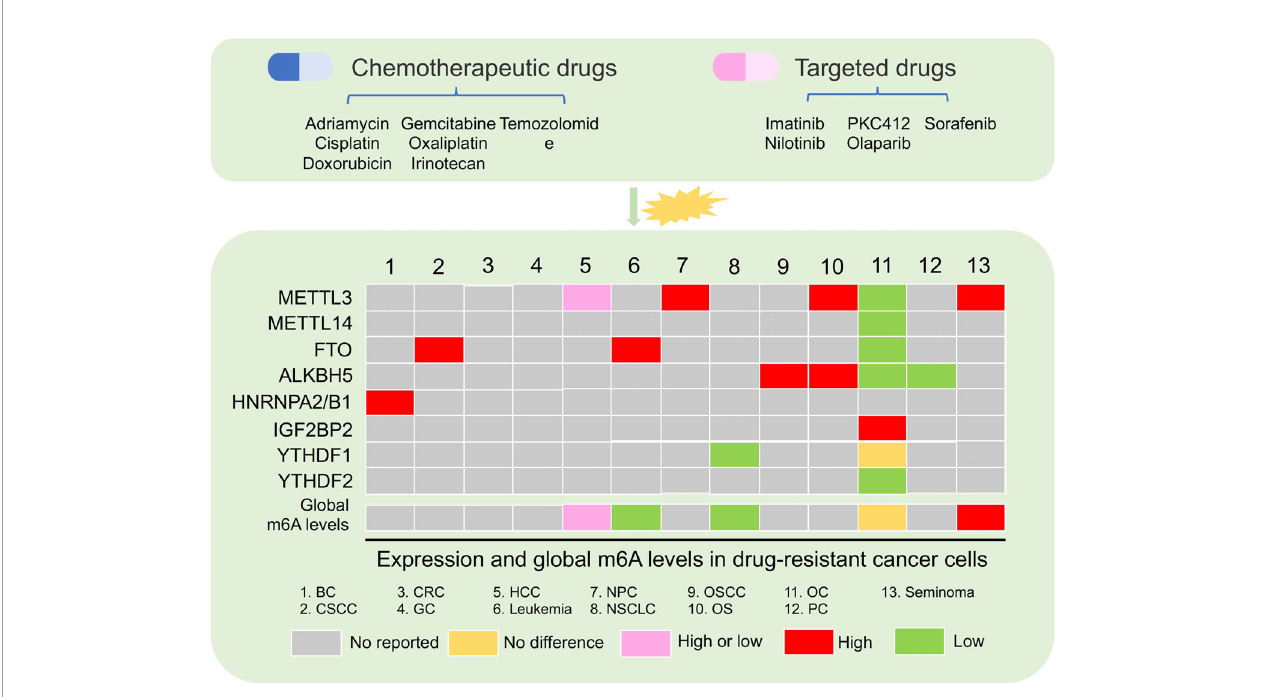
FIGURE 2 | Aberrant m6A regulator and global m6A levels in drug-resistant cancer. The changes in m6A levels and the expression of m6A regulators were present after chemotherapy and targeted drug treatment in multiple cancer. BC, breast cancer; CSCC, cervical squamous cell carcinoma; CRC, colon cancer; GC, gastric cancer; HCC, hepatocellular carcinoma; NPC, nasopharyngeal carcinoma; NSCLC, non-small cell lung cancer; OSCC, oral squamous cell carcinoma; OS, osteosarcoma; OC, ovarian cancer; PC, pancreatic